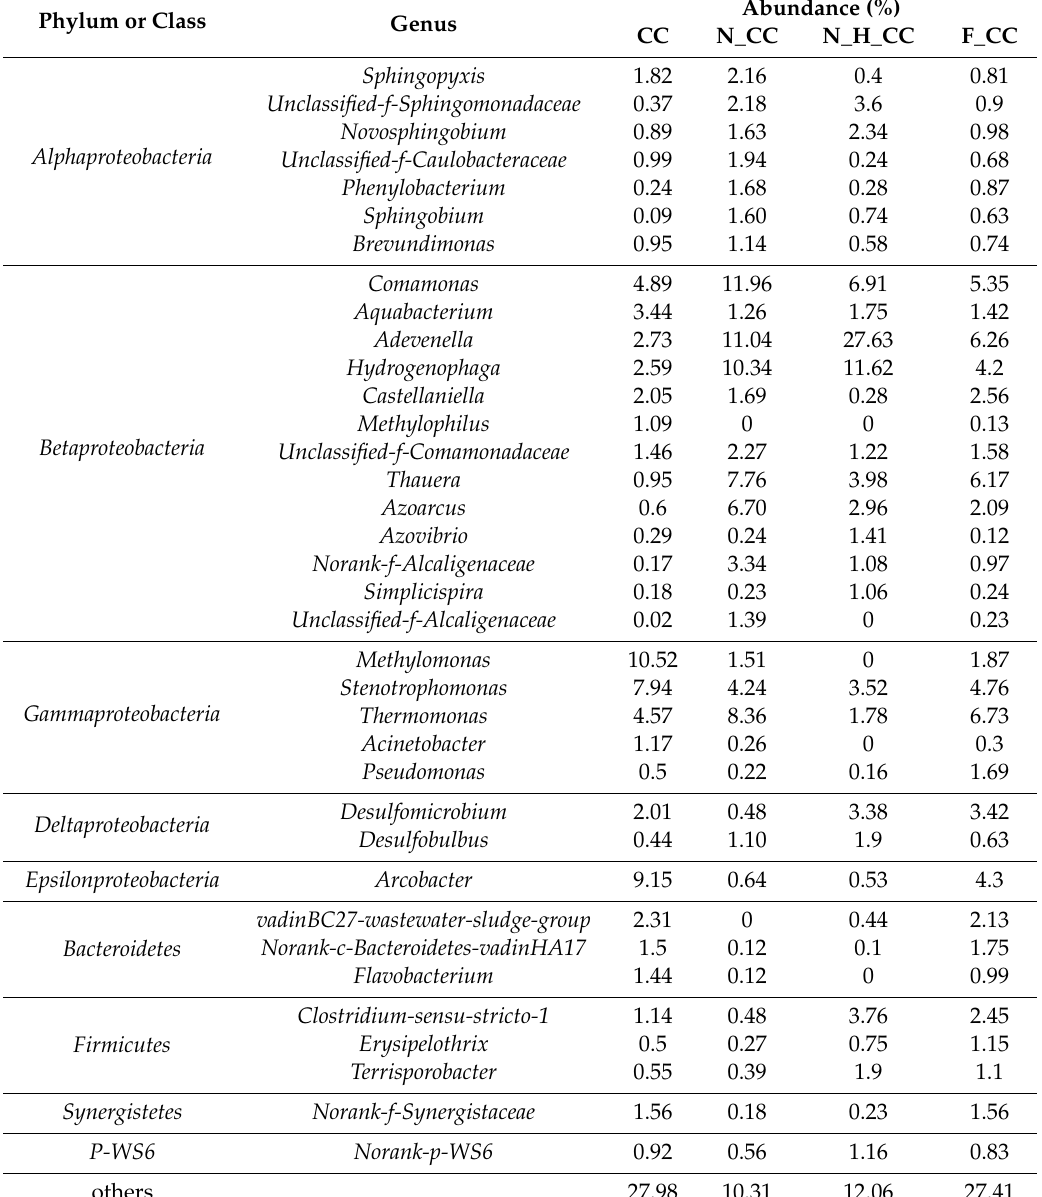
Table 2. Di ff erences in relative abundance of the bacterial genera with CC, N_CC, N_H_CC, and